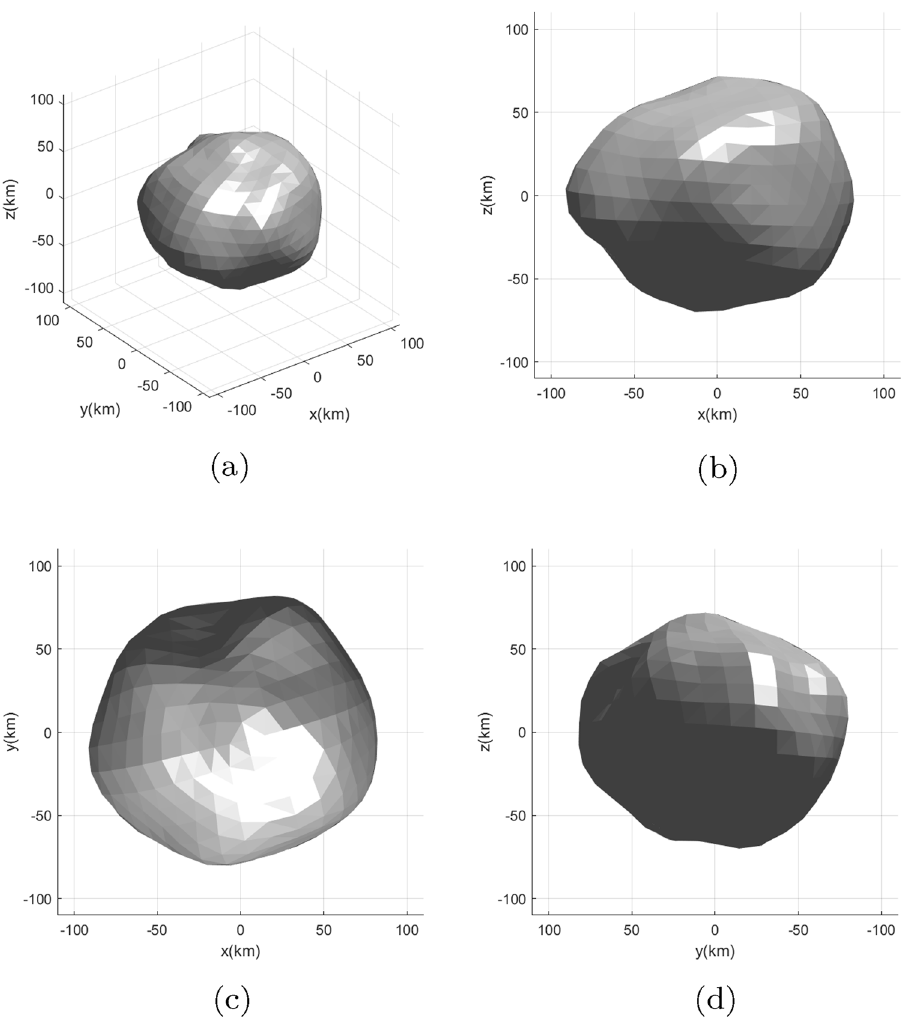
Figure 2: The polyhedron model of asteroid Minerva consists 402 vertices and 800 triangular faces in total. ( a ) 3D view. ( b ) y + viewing angle. ( c ) z + viewing angle. ( d ) x + viewing